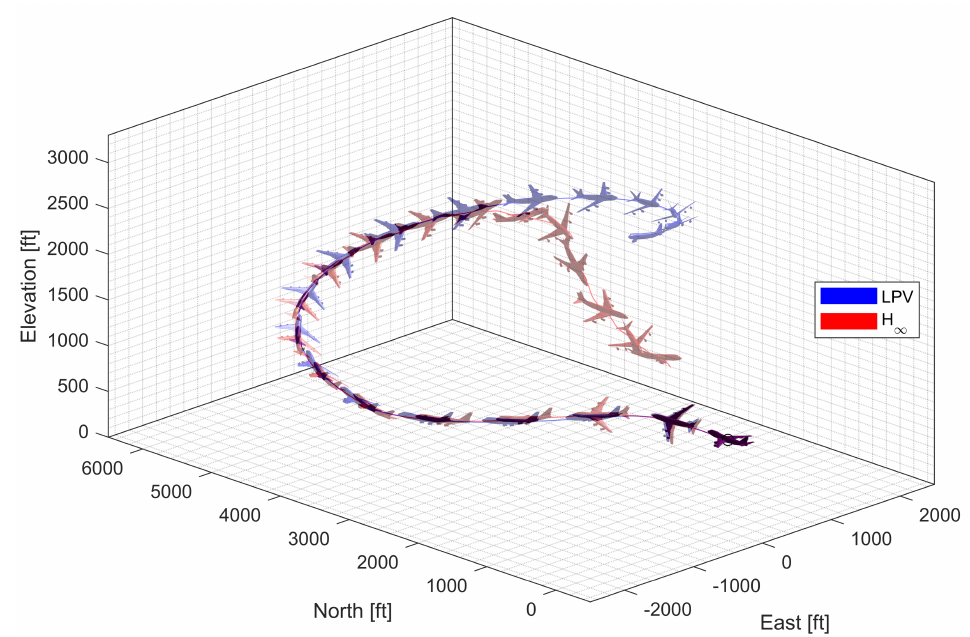
Figure 26. Flight trajectory of the helical ascent.